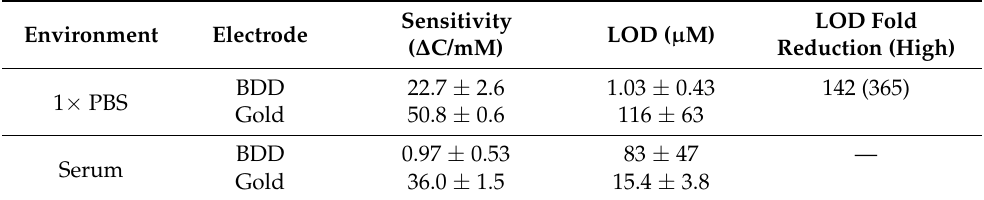
Figure 4. Hexacyanoferrate (II/III) titration and linear regression curves for ( a ) boron-doped diamond and ( b ) gold electrodes in human serum. Table 1. Summary of analytical performance characteristics between boron-doped diamond and gold electrodes for hexacyanoferrate (II/III) titration.